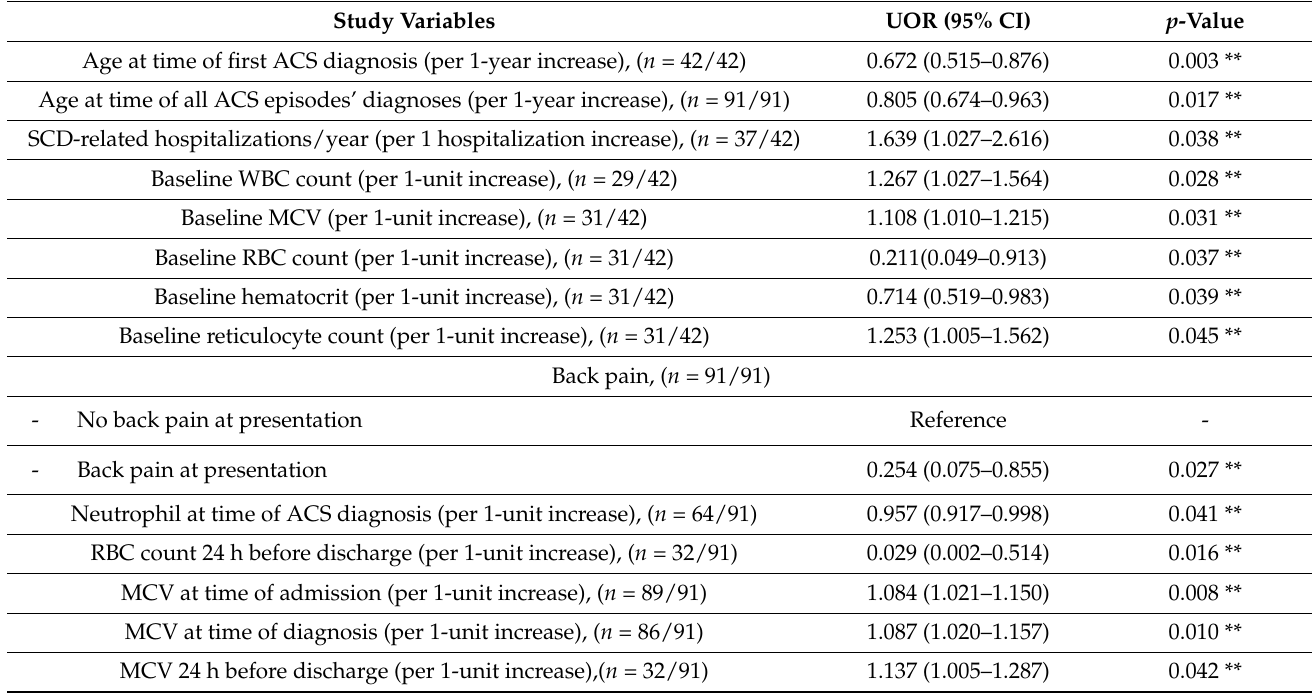
Table 5. Univariable binary logistic regression analysis of potential factors associated with devel- oping recurrent ACS.